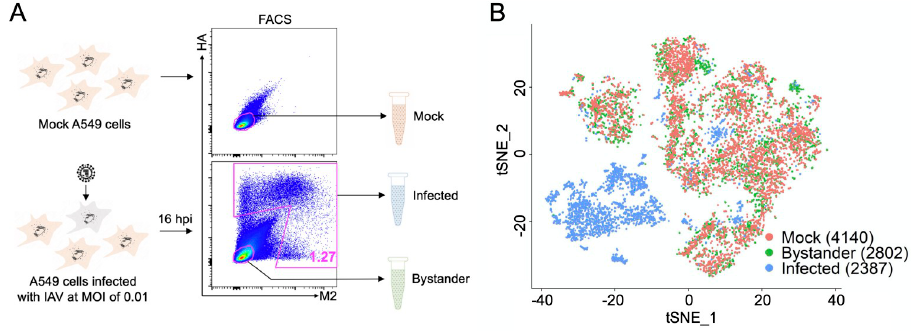
Fig 1. Generation of viral and host transcriptional data for thousands of singly infected cells. (A) Schematic depicting our strategy for generating single cell RNAseq libraries from thousands of cells infected at low MOI. In brief, we infect A549 cells with Cal07 or Perth09 at MOI = 0.01 to ensure that infected cells are infected with a single virion. We then block secondary spread with NH 4 Cl treatment to make sure infection timing is uniform across all infected cells. Finally, we sort “infected” and “bystander” cells based on surface expression of HA and/or M2 and immediately generate single cell RNAseq libraries from these sorted cell populations using the 10X Chromium device. In parallel, mock cells are sorted and used as uninfected controls. (B) tSNE dimensionality reduction plot showing the extent of overlap between 3 indicated cell populations from Perth09 experiment clustered based on transcriptional similarity.